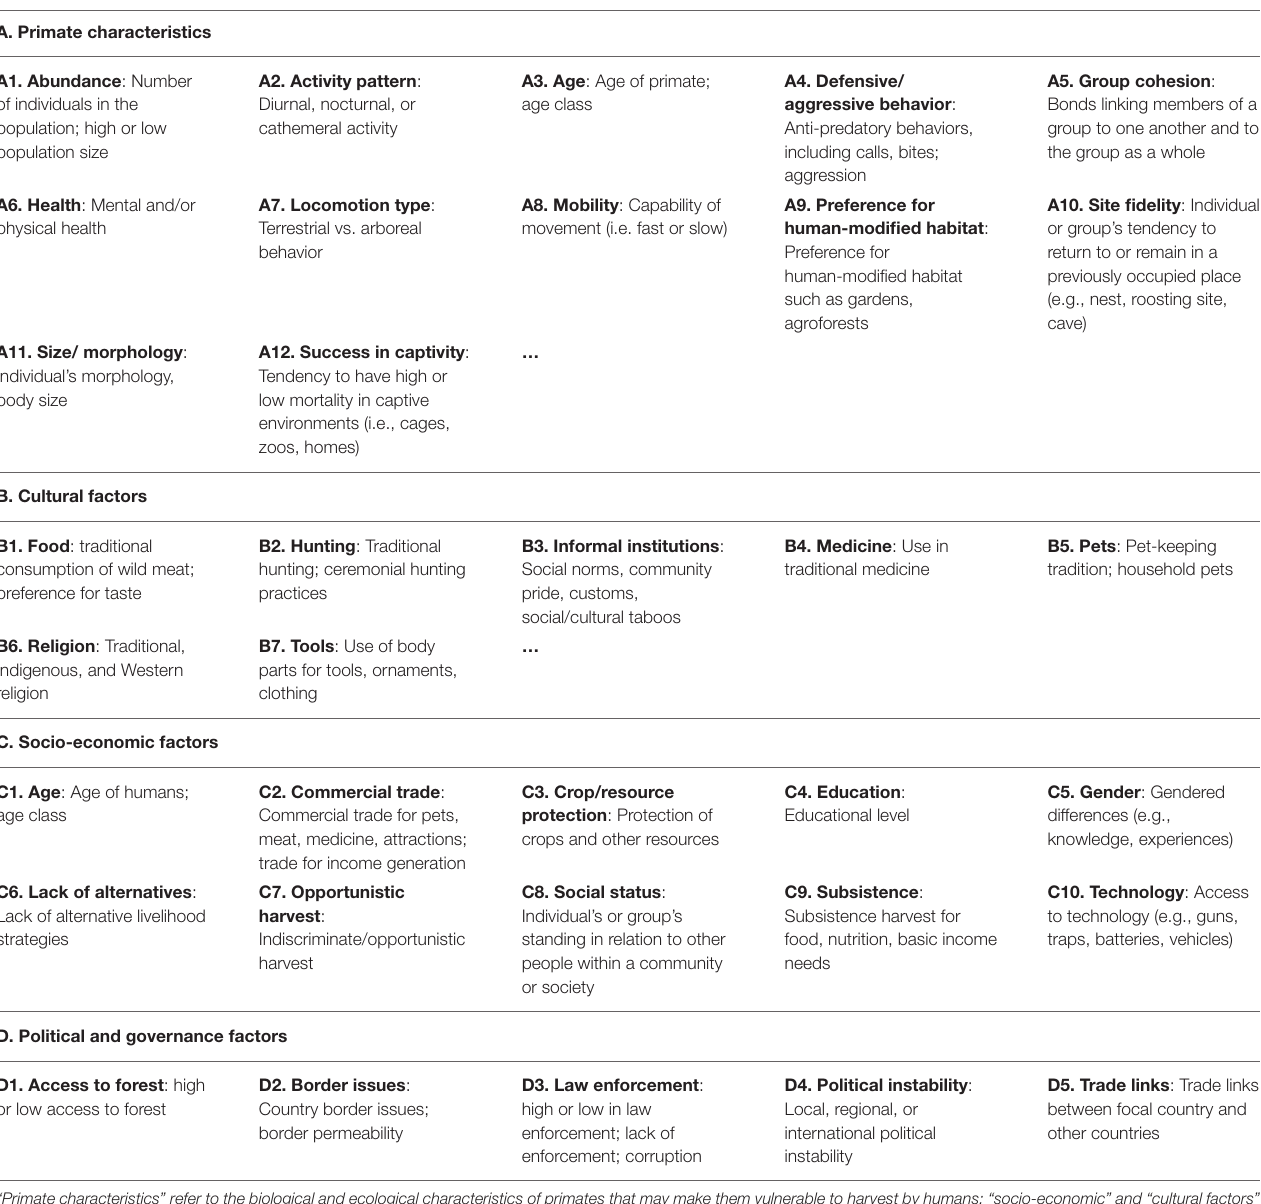
TABLE 1 | Social and ecological factors used to guide literature review and